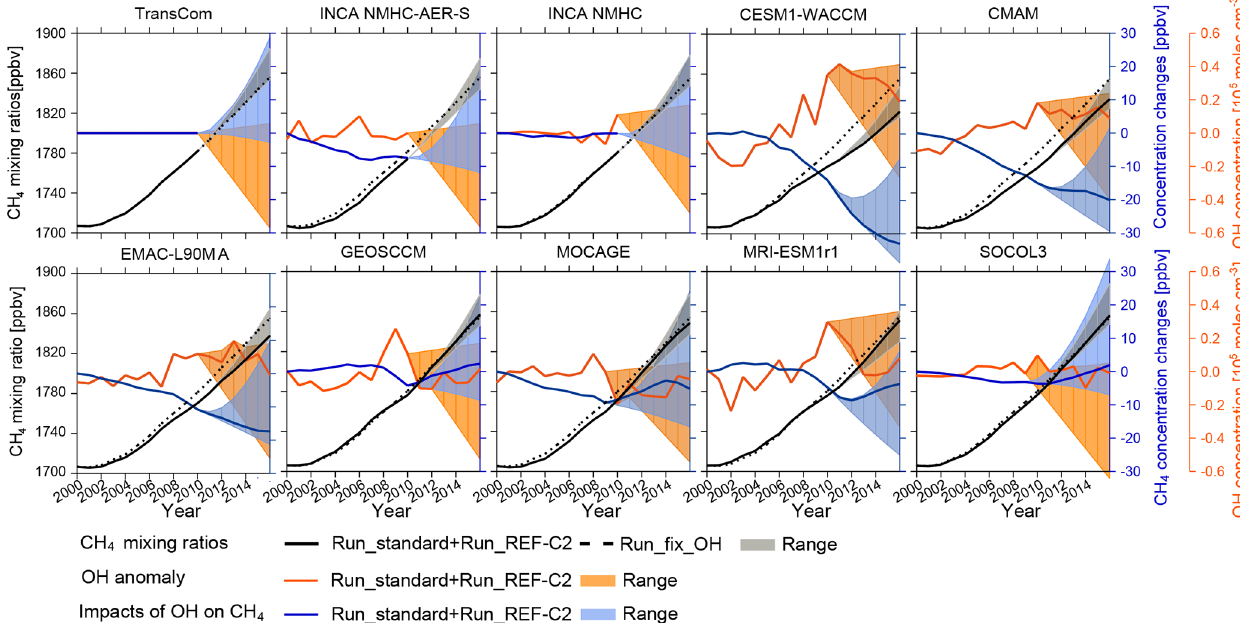
Figure 7. Time series of global tropospheric CH 4 mixing ratios and [OH] associated with the model experiments listed in Table 2. The black lines represent the evolution of CH 4 mixing ratios with varying (solid lines) or with constant (dashed lines) OH. The varying OH case is obtained using OH inputs from Run_standard from 2000 to 2010 followed by Run_REF-C2 from 2011 to 2016 (see Table 2). The blue solid lines represent the corresponding differences between the simulations with varying OH and with constant OH. The orange solid line represents the corresponding anomalies in tropospheric [OH] (with the average over 2000–2010 as a reference). The shaded areas correspond to the range obtained from all simulations over 2010–2016 (Table 2) for tropospheric CH 4 mixing ratios (gray), for changes in tropospheric CH 4 mixing ratios (blue), and for changes in tropospheric [OH]